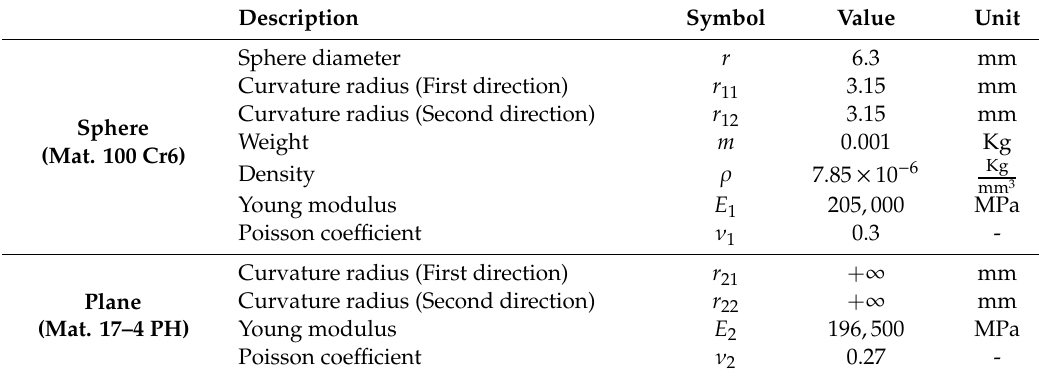
Table 1. The geometrical and material parameters used in the